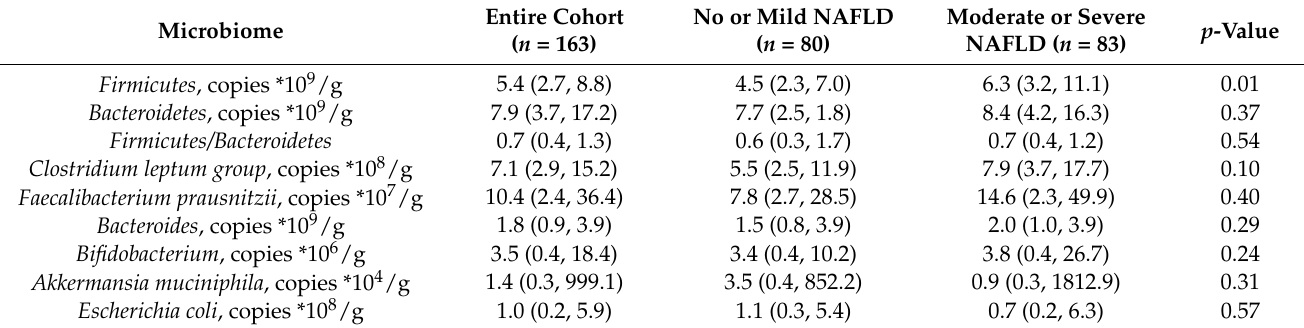
Table 2. Microbiota distribution in the study